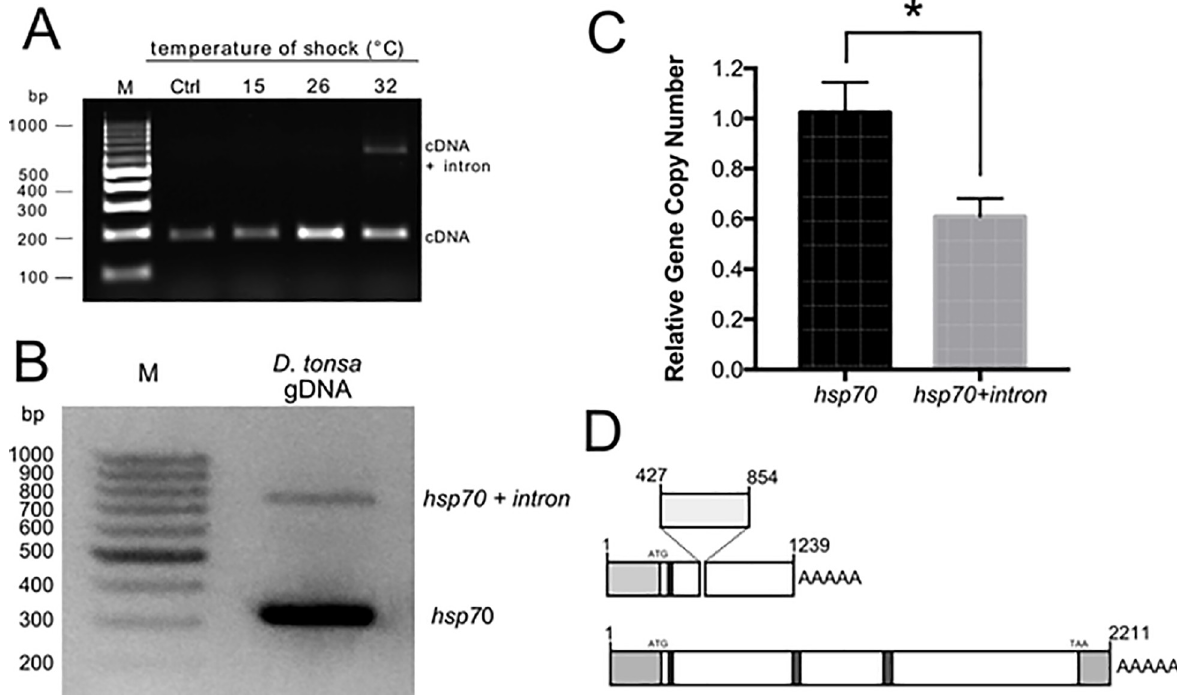
Fig 2. Identification of an Hsp70 pseudogene in Diamesa tonsa . ( A ) Agarose gel of hsp70 PCR products from D . tonsa larvae control (Ctrl, 4˚C) or maintained for 1 h at 15, 26, and 32˚C. All PCR products are amplified from cDNA with primers for hsp70 ( Table 1 ). ( B ) Agarose gel electrophoresis of the PCR products amplified from D . tonsa genomic DNA with hsp70 sequence specific primers hsp70 F and hsp70 R ( Table 2). ( C ) Relative gene copy number of hsp70 and hsp70 + intron assessed by Real-PCR analysis (n = 4) (Student t -test, � p � 0.05). ( D ) Schematic representation of the two hsp70 transcripts: light grey boxes are the 5 0 and 3 0 UTR, dark grey boxes indicated the position of the three characteristic HSP70 family domains.